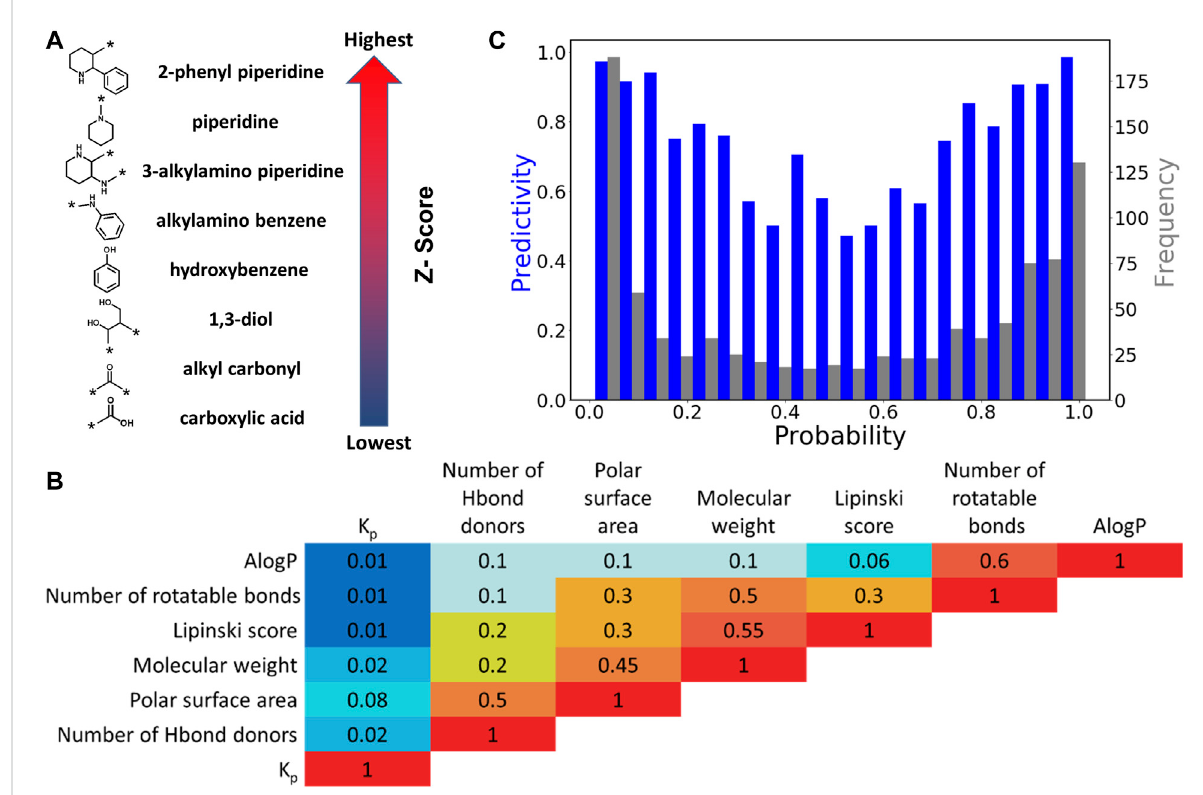
FIGURE 2 Leadscope modelanalysis. (A) Selected chemical features withhighestandlowest Z-scores.The arrowshows theorderof Z-scores associated withfeaturesinthemodel. (B) Correlation ( R 2 )betweenpairsofphysicochemicalfeatures. (C) Histogramofthepredictivity(bluebars)andfrequency (grey bars) as a function of probability in LS